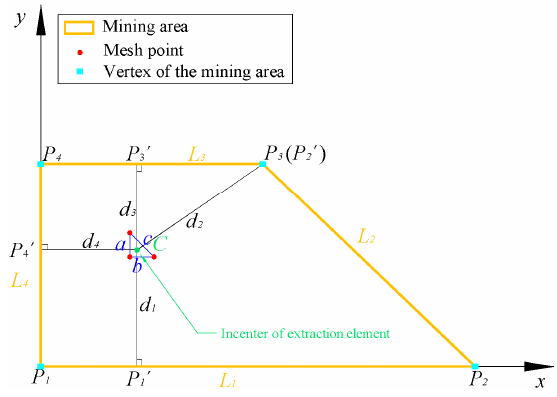
Figure 4. Geometry of mining area boundary lines and the incenter of an extraction element.